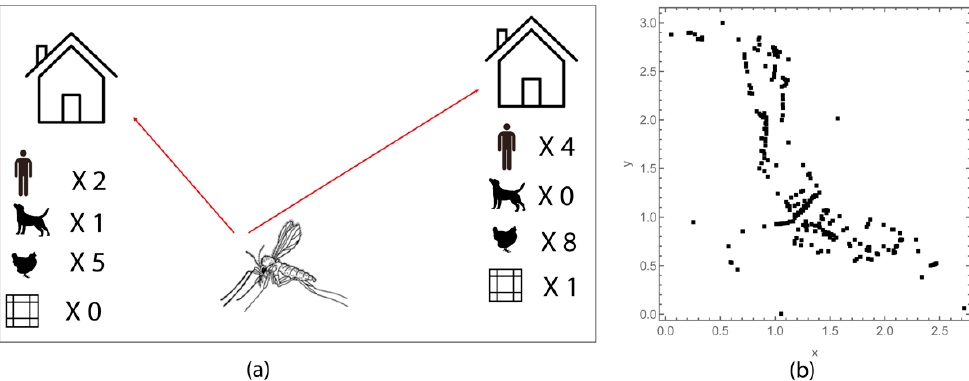
Figure 1. ( a ) Conceptual representation of host choice model: the behaviour of a sand fly depends on the distance and the strength of stimulus received from various sources: hosts (humans, dogs and chickens) and synthetic pheromone traps. ( b ) Location of households [30].